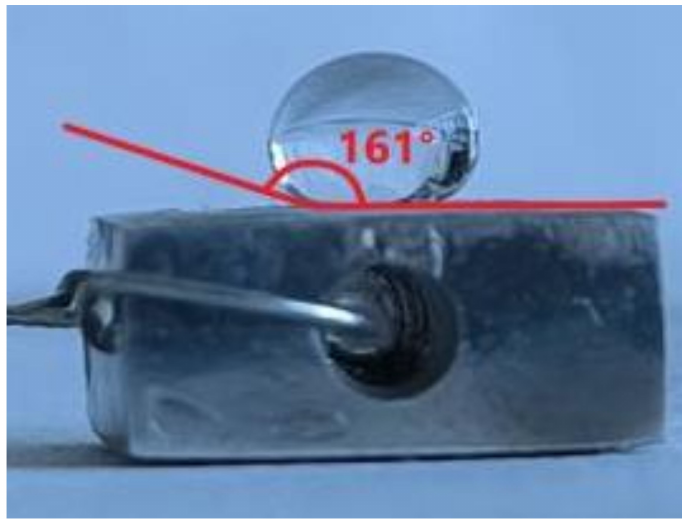
Figure 1. Superhydrophobic coating obtained in the